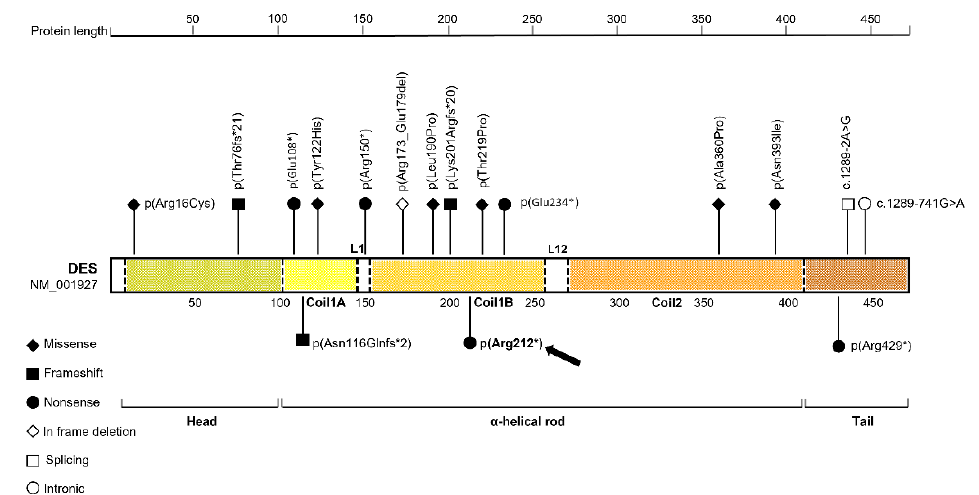
Figure 3. Structural organization of the human desmin and graphical representation of the distribution of bi-allelic variants in DES gene. The arrow indicated the variation found in our patient. The different domains and segments of desmin, are painted with distinct patterns. Homozygous and compound heterozygous bi-allelic mutations are aligned according to their location, over the entire DES gene. Nonsense, missense, frameshift, deletions, splicing and intronic mutations are reported in the protein graph using different symbols.